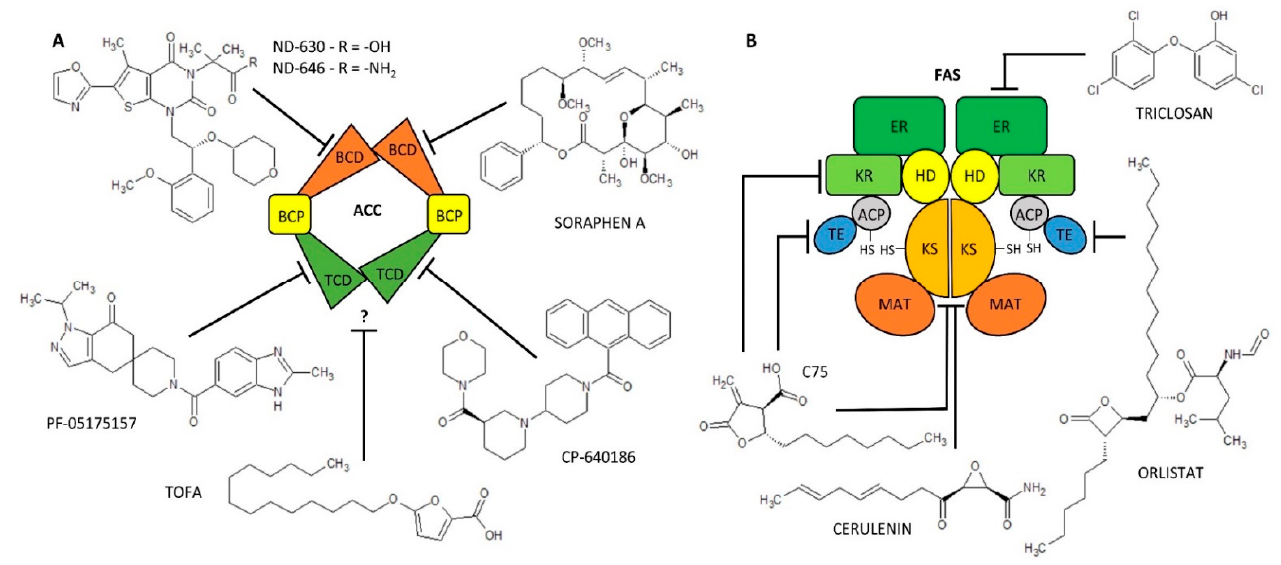
Figure 3. Scheme of acetyl-CoA carboxylase (ACC) ( A ) and fatty-acid synthase (FAS) ( B ) struc- ture/domains and their inhibitors. ACC domains: BCD, Biotin Carboxylase Domain; BCP, Biotin- containing carboxyl Carrier Protein; TCD, Carboxyl Transferase Domain. FAS domains: MAT, Mal- onyl-/Acetyl-Transferase; ACP, Acyl Carrier Protein; KS, β -Ketoacyl Synthetase; KR, β -Ketoacyl Re- ductase; HD, β -Hydroxylacyl Dehydratase; ER, Enoyl Reductase; TE, Thioesterase. ? = it is not de- scribed which domain is affected.